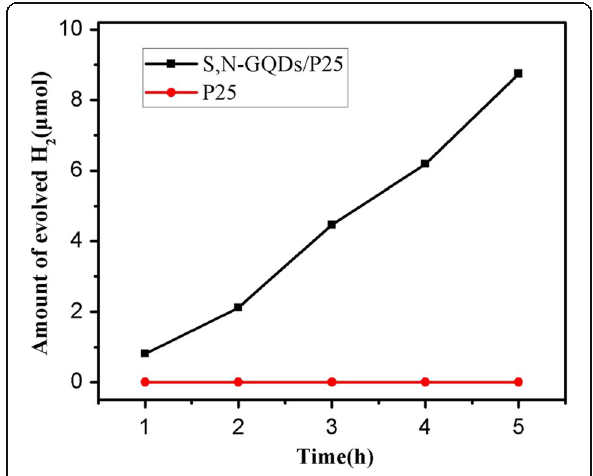
Fig. 7 Photocatalytic H 2 generation rates of pure P25 and S,N-GQD/ P25 composites (3 wt.% S,N-GQD) under visible light